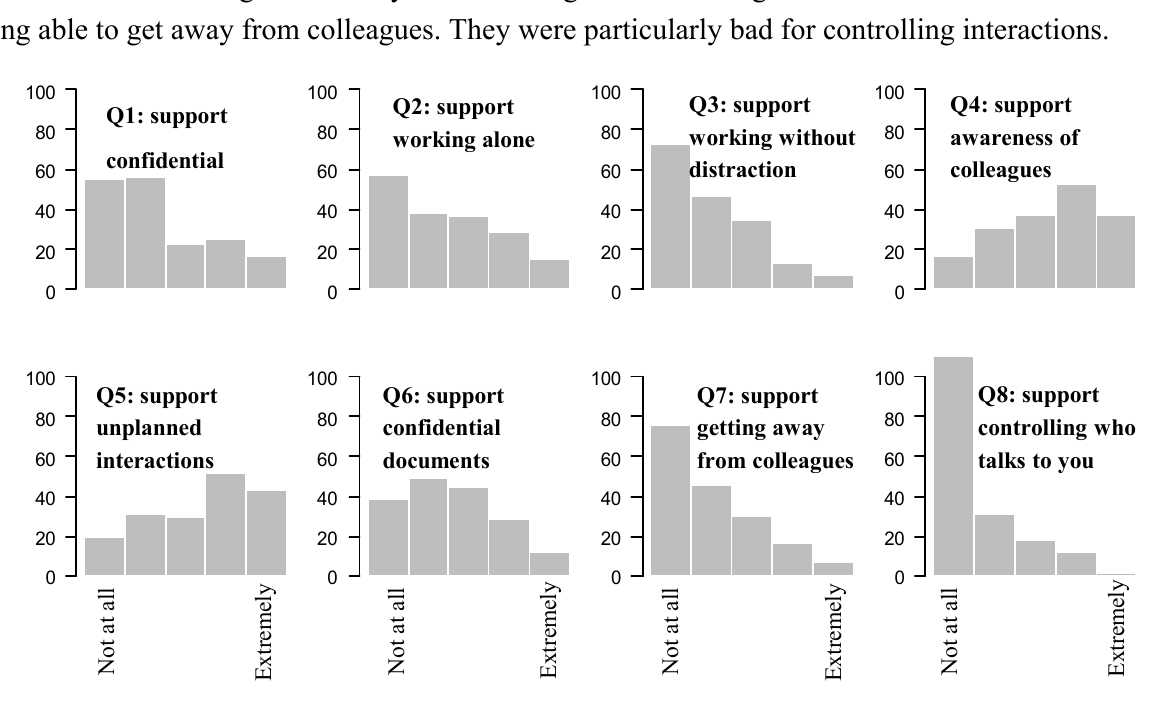
Figure 1. The degree to which all offices supported different behaviours. Overall the offices were thought to be good for interaction and not so good for